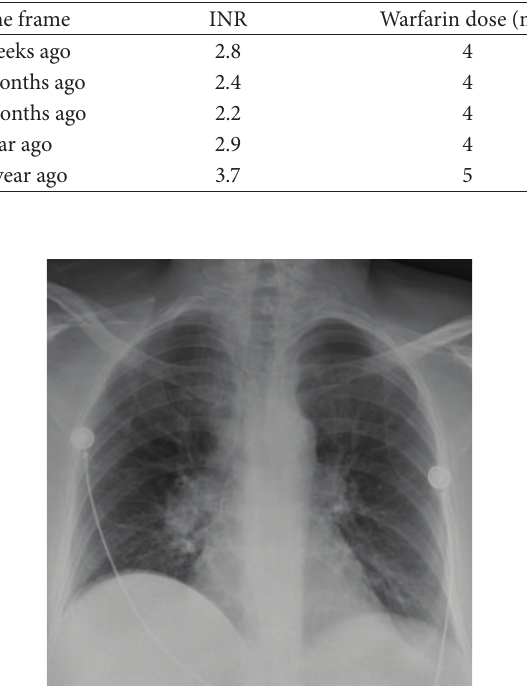
Figure 1: Chest X-ray.